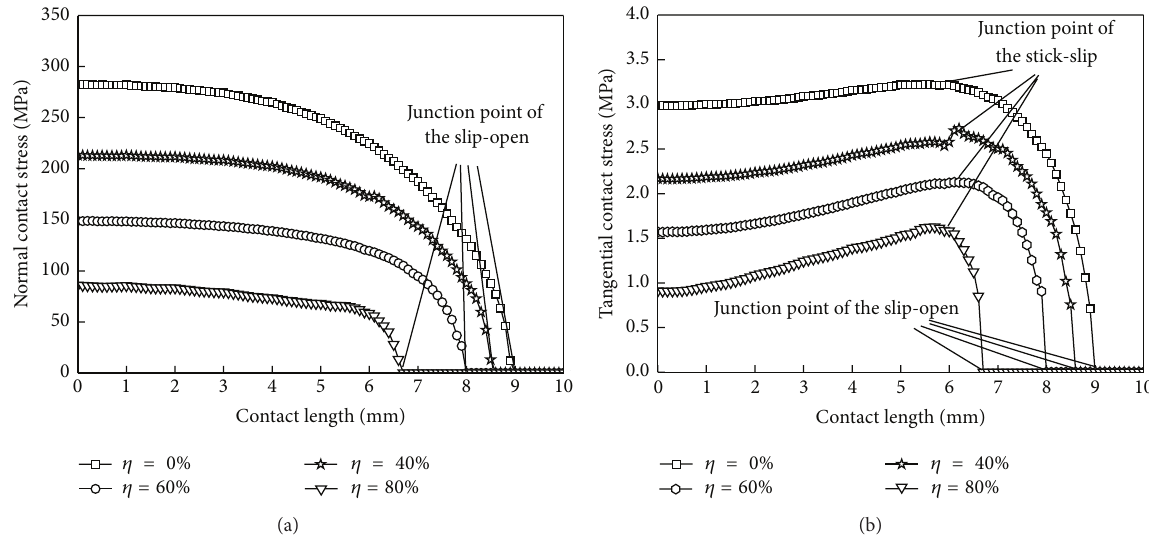
Figure 12: Contact stress distribution curves under different hollow degrees. (a) Normal contact stress and (b) tangential contact stress.